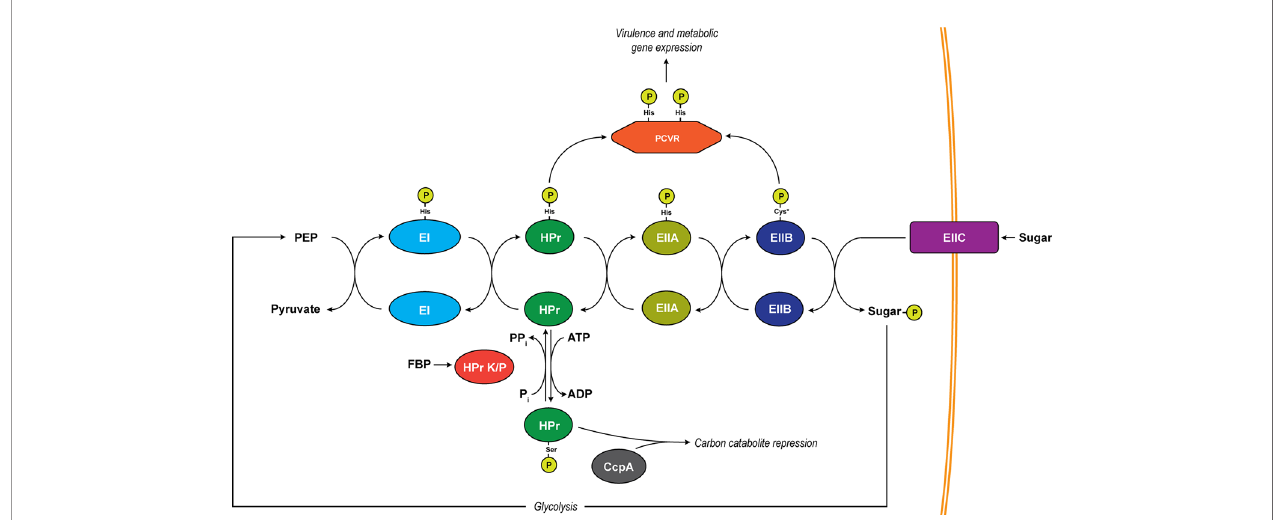
FIGURE 1 | The PTS system. Depicted is a generalized schematic of the PTS that exists in Firmicutes. Phosphates are transferred across conserved histidine residues on EI, HPr, and EIIA. A conserved cysteine serves as the site of phosphorylation on EIIB (asterisk indicates an exception to this in mannose-speci fi c EIIBs which are phosphorylated on a histidine). Major regulatory pathways diverging from the pathway include PCVRs which are putatively controlled through phosphorylation on PRD histidine residues by HPr and/or EIIB proteins as well as carbon catabolite repression through phospho-Ser-HPr. The transition of unphosphorylated HPr to phospho- Ser-HPr is initiated by abundance of ATP as well as the activation of HPr K/P by fructose-1,6-bisphosphate (FBP). HPr K/P can also transfer the phosphate from phospho-Ser-HPr by moving it from HPr to a substrate phosphate (P i ), resulting in the formation of pyrophosphate (PP i